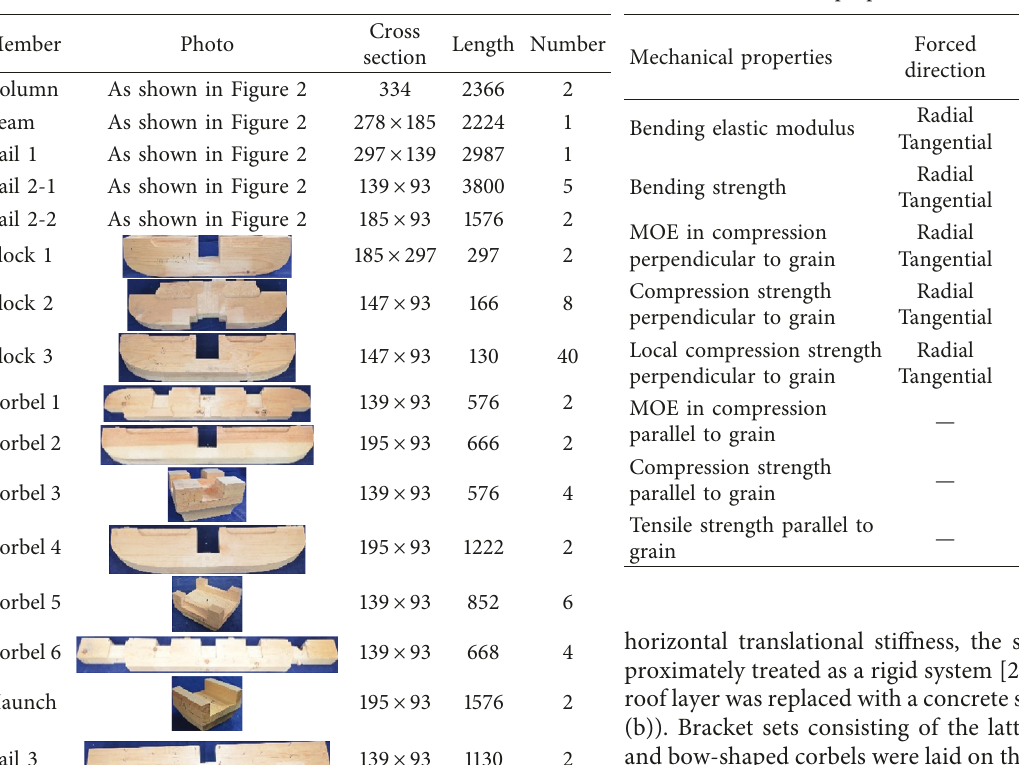
Table 1: Sizes of the main elements (all dimensions in mm). Table 2: Material properties of the full-scale test